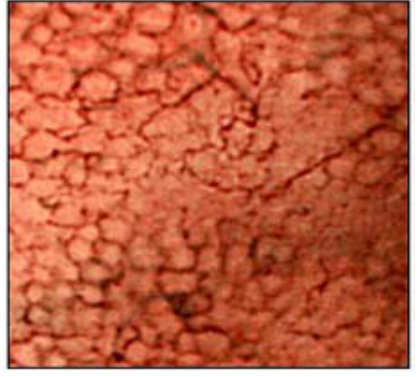
FIGURE 10. Stomach: Oxyntic mucosa in the fundus; narrow-band imaging at low magnification. Supepithelial capillaries with a honeycomb pattern around the opening of the gastric pits. Collecting veins colored in cyan with a starfish design.